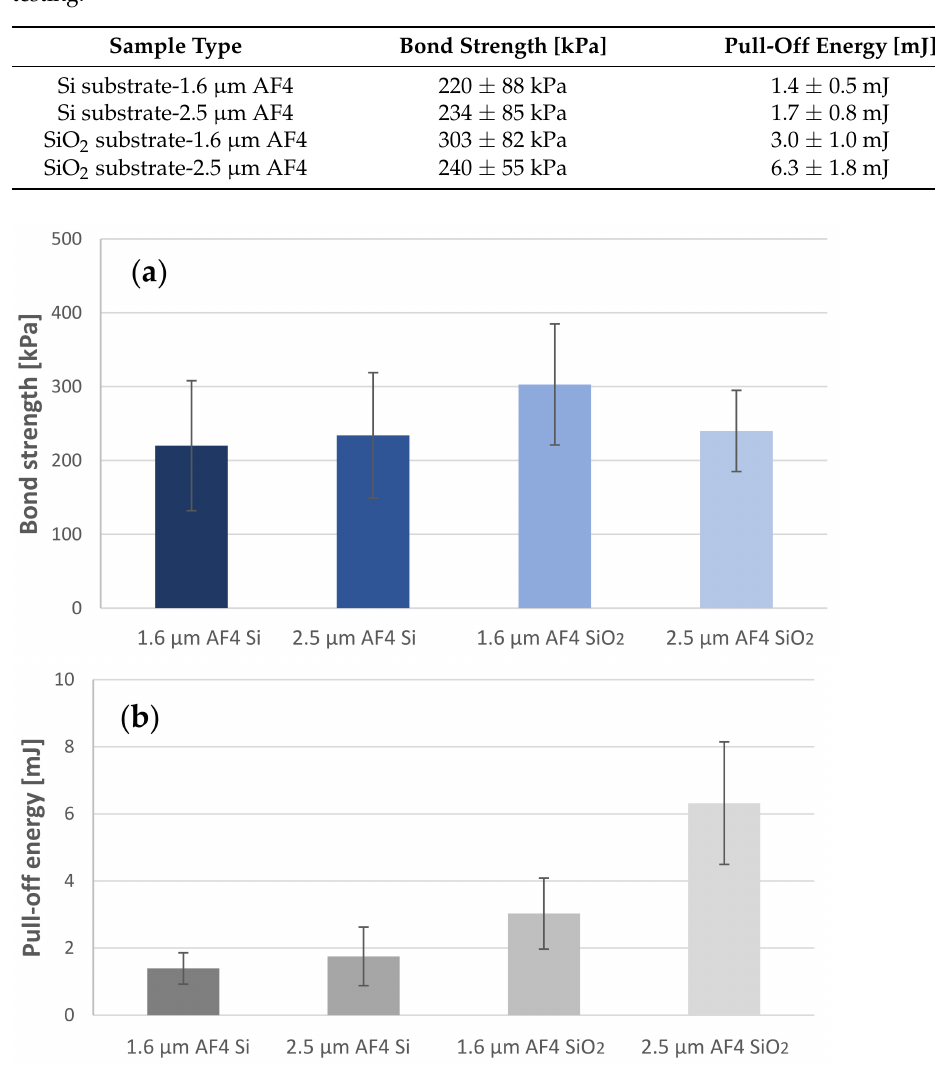
Table 1. Bond strength and pull-off energy results for all the investigated AF4 coatings by pull-off testing.